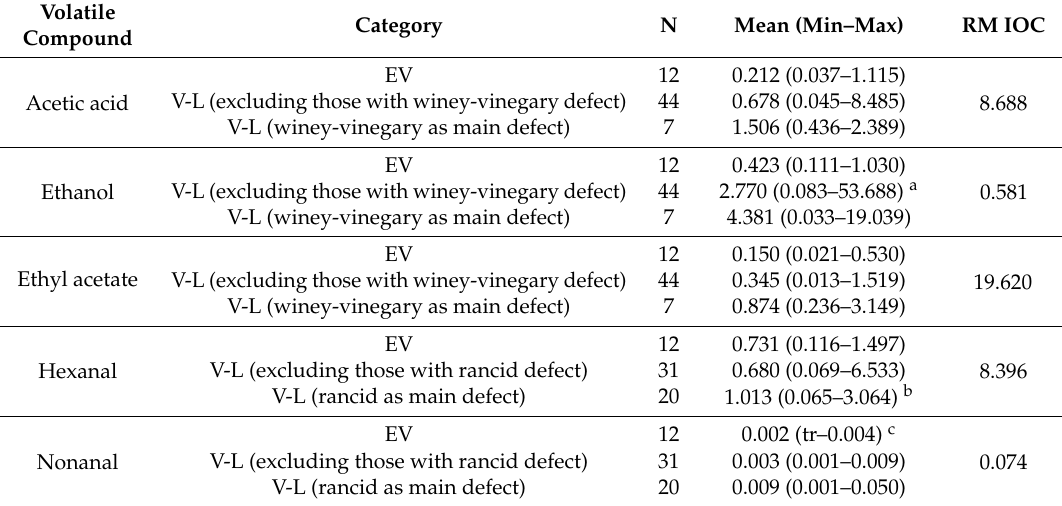
Table 2. Relative areas of volatile compounds selected to emulate winey-vinegary and rancid defects in VOOs in a set of 63 samples and in RMs provided by the IOC for each of the defects (RM